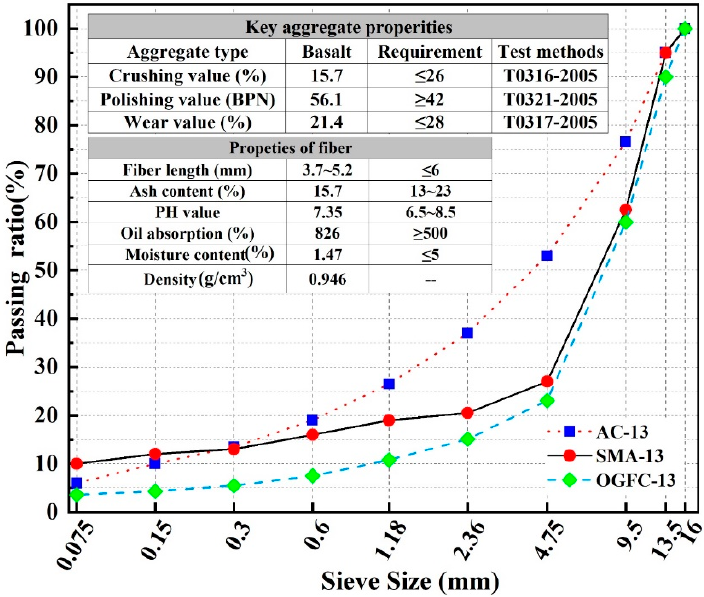
Figure 2. The gradation of three type of asphalt mixture. Table 1. The density of basalt aggregate at all levels.